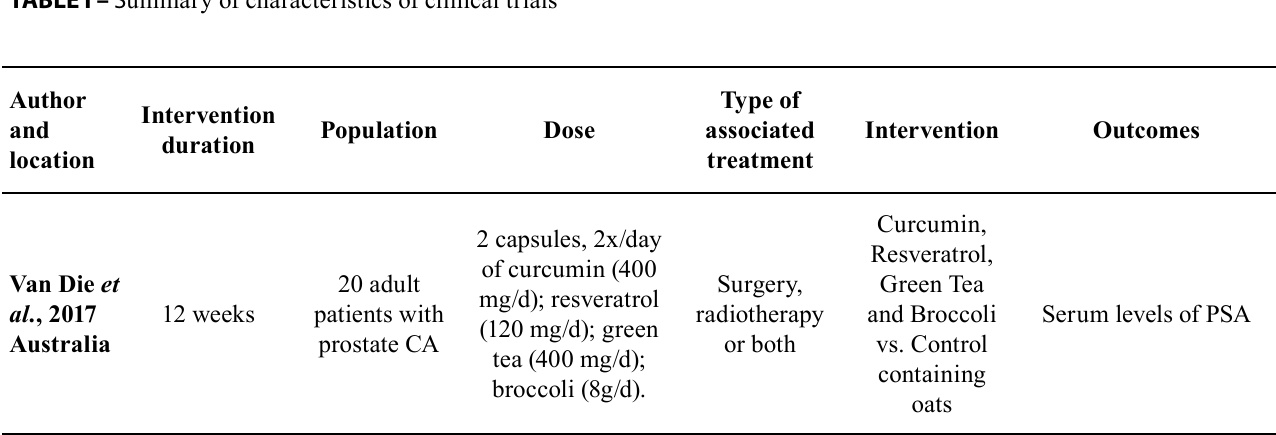
TABLE I – S ummary of characteristics of clinical trials